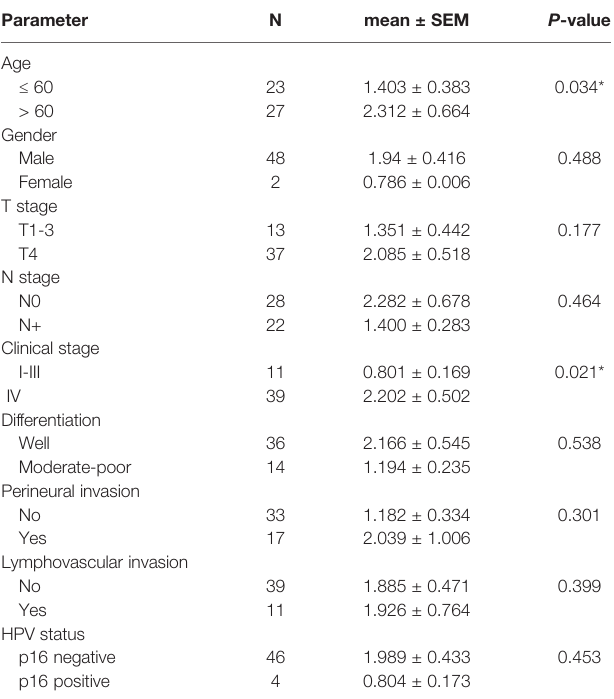
TABLE 1 | Association between tumor burden and clinical